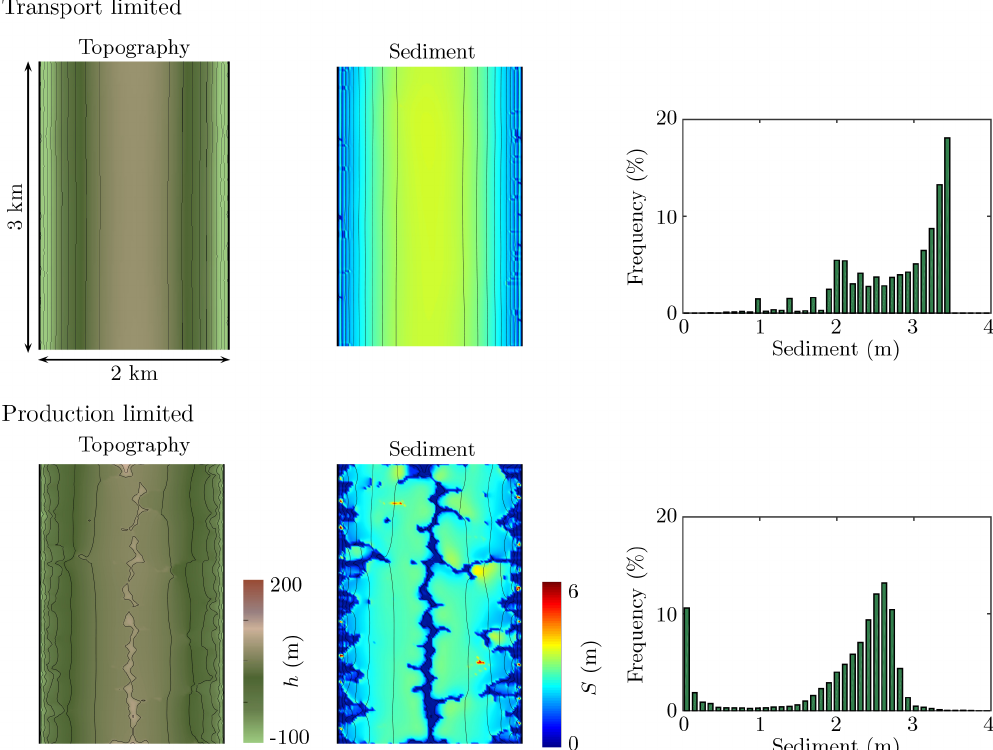
Figure 9. Results for a transport-limited (top) and a production-limited model (bottom). k e = 0 . 005 ◦ Ca − 1 for the transport-limited model and 0 . 0001 ◦ Ca − 1 for the production-limited model. This is the only difference between the two model experiments, which both have − 6 < MAT < 0 ◦ C and L = 2km. Left panels: modelled topography after 4Myr. The contour spacing is 10m. Middle panels: sediment thickness in the landscape after 4Myr. Right panels: histogram of sediment thickness for the two cases. Almost all of the landscape has > 2m sediment in the transport-limited case, and sediment thickness gently decreases from 3.5m in the centre to about 2m along the edges. In contrast, the sediment distribution is highly bimodal in the production-limited case. There is no sediment along the edges and on tors that protrude up through the sediment cover along the central ridge. In the other parts of the landscape sediment covers are mostly 2–3m thick.